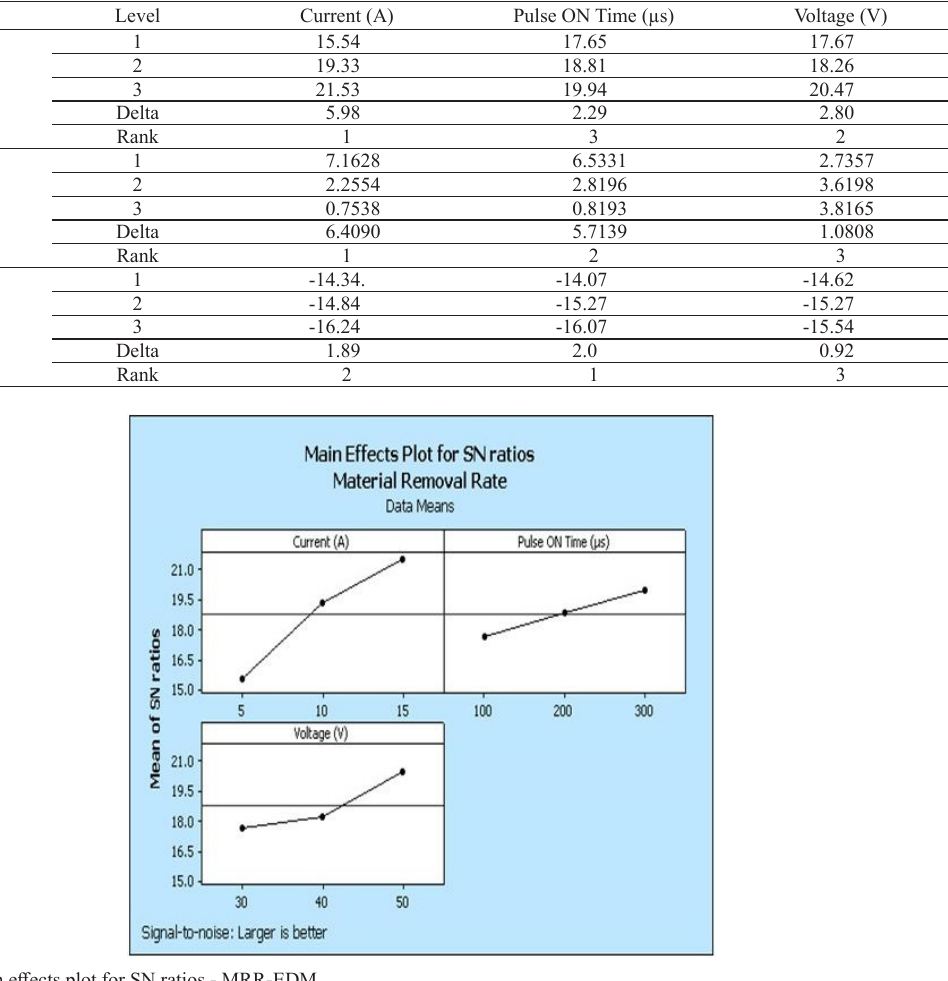
Figure 3. Main effects plot for SN ratios - MRR-EDM.